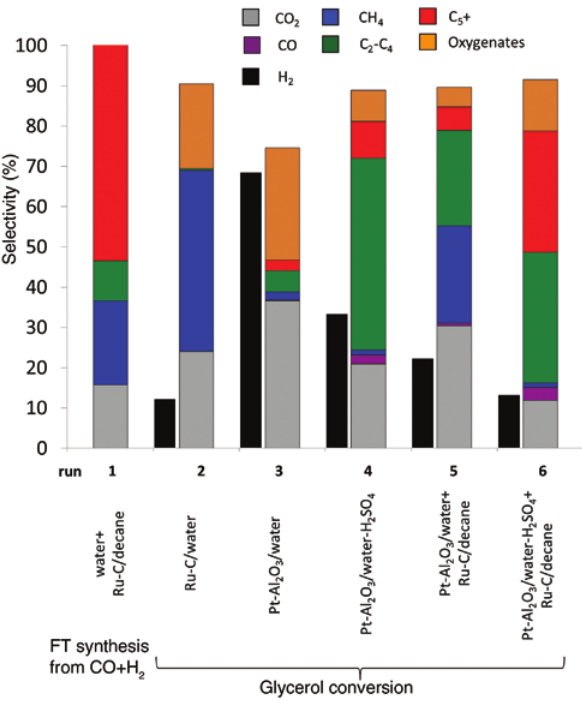
Figure 5: Distribution of the products during FT synthesis (T = 220 ° C, 40 ml of water, 10 ml of decane, 0.5 g Ru-C, p[CO] = 10 bar, p[H ] = 20 bar , conversion of CO 80%), APR and the combined 2 process APR-FTS (T = 220 ° C, 40 ml of water with 5 g glycerol, 0.1 M H SO , 0.5 g Pt-Al O , 10 g decane, 0.5 g Ru-C, p[N 2 4 2 3 conversion of glycerol of about 60%.